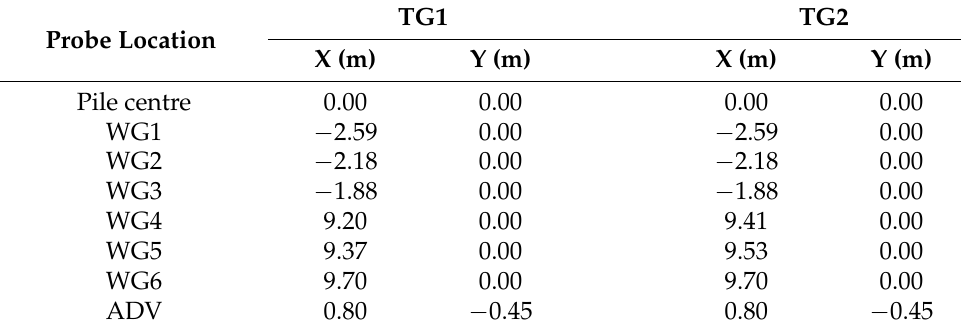
Table 2. Locations of probes in small scale test.